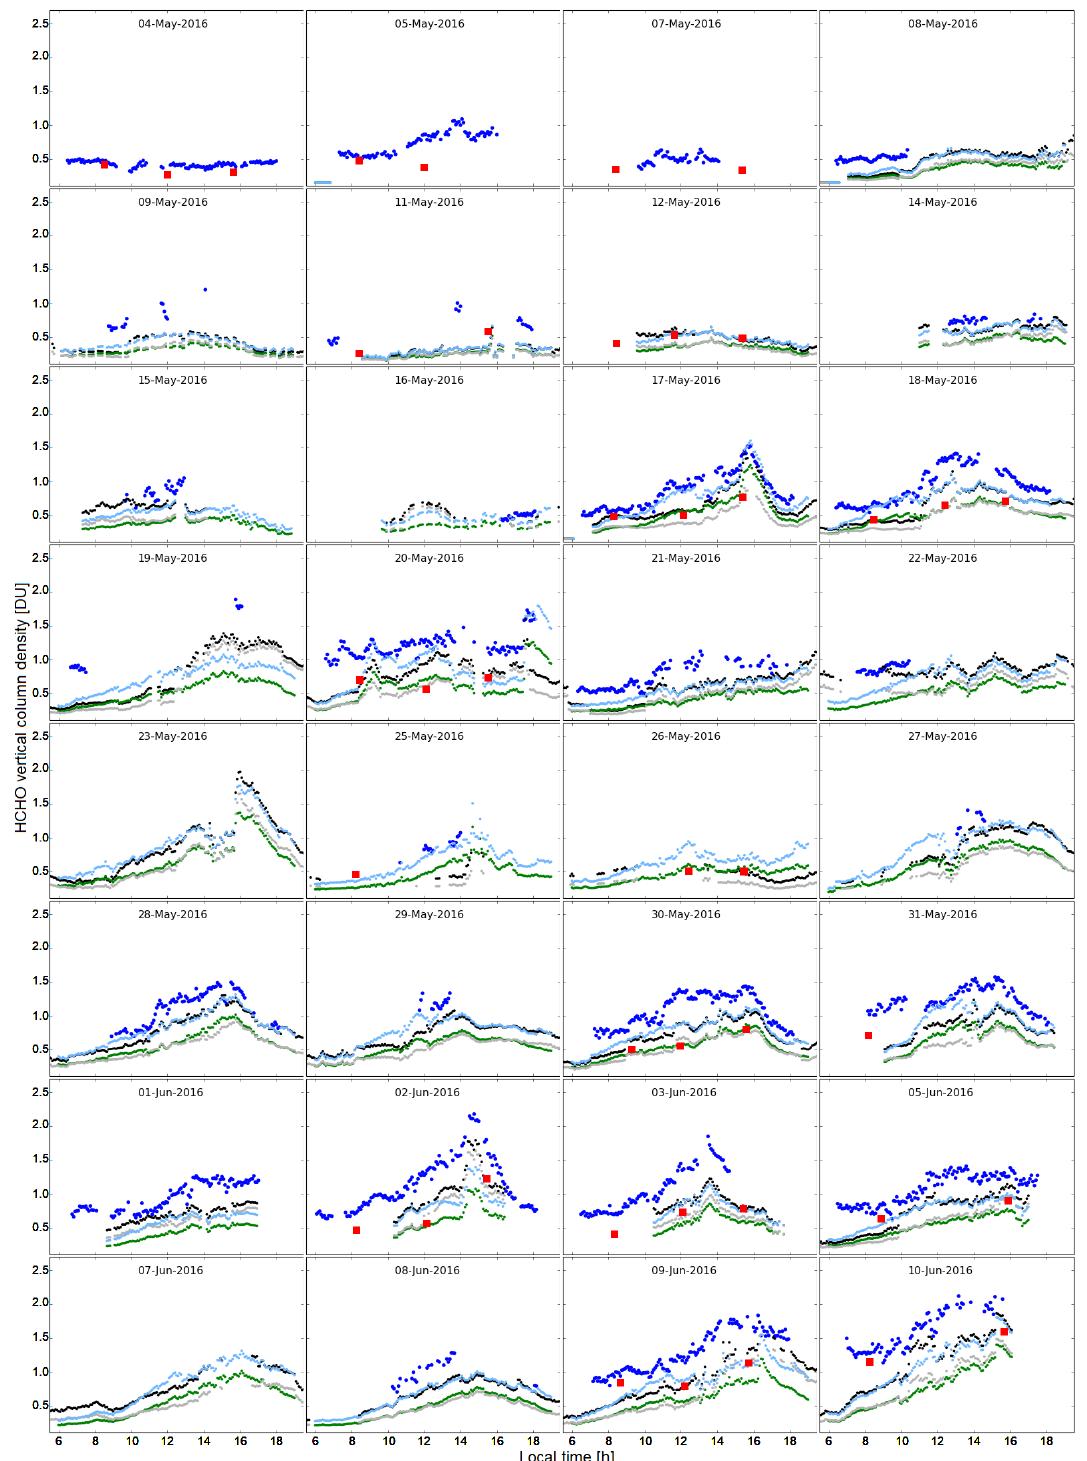
Figure 7. Vertical column densities at Olympic Park during KORUS-AQ derived from Pandora direct-sun measurements ( • ); DC-8 (from surface to 12.77km, (cid:4) ); and surface concentrations and profile shapes: (1) box with a median MLH (green), (2) box with a measured MLH (grey); (3) box + exponential profile with a median MLH (light blue), and (4) box + exponential profile with a measured MLH